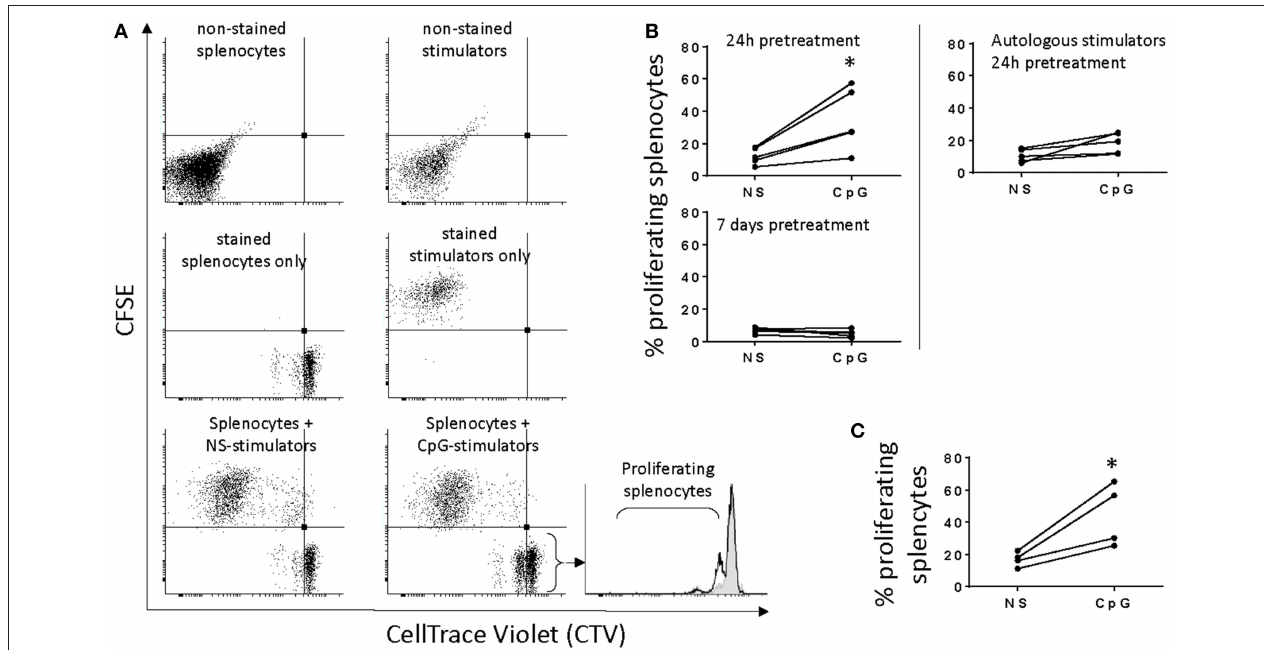
FIGURE 2 | Short, but not prolonged treatment of salmon MPs with CpGs upregulates their allostimulatory activity. (A) , adherent HK MPs were stained with CFSE upon 24h of stimulation with 2 µ M CpGs. Splenocytes stained with CellTrace Violet (CTV) were used as responders. The dot plots show that a significant number of stimulators take up CTV which necessitates their staining with CFSE in order to distinguish them from proliferating responders with reduced CTV staining. The CFSE-negative events were gated and displayed in histograms to quantify the percentage of proliferating splenocytes with reduced CTV staining. In the representative histogram (bottom right), responders were cultured with non-stimulated (NS) MPs from another individual (filled gray area), and stimulators pretreated with CpGs for 24h (black contour). (B) , Stimulators pretreated with CpGs for 24h but not 7 days show increased allostimulatory capacity ( n = 5). Autologous stimulators did not